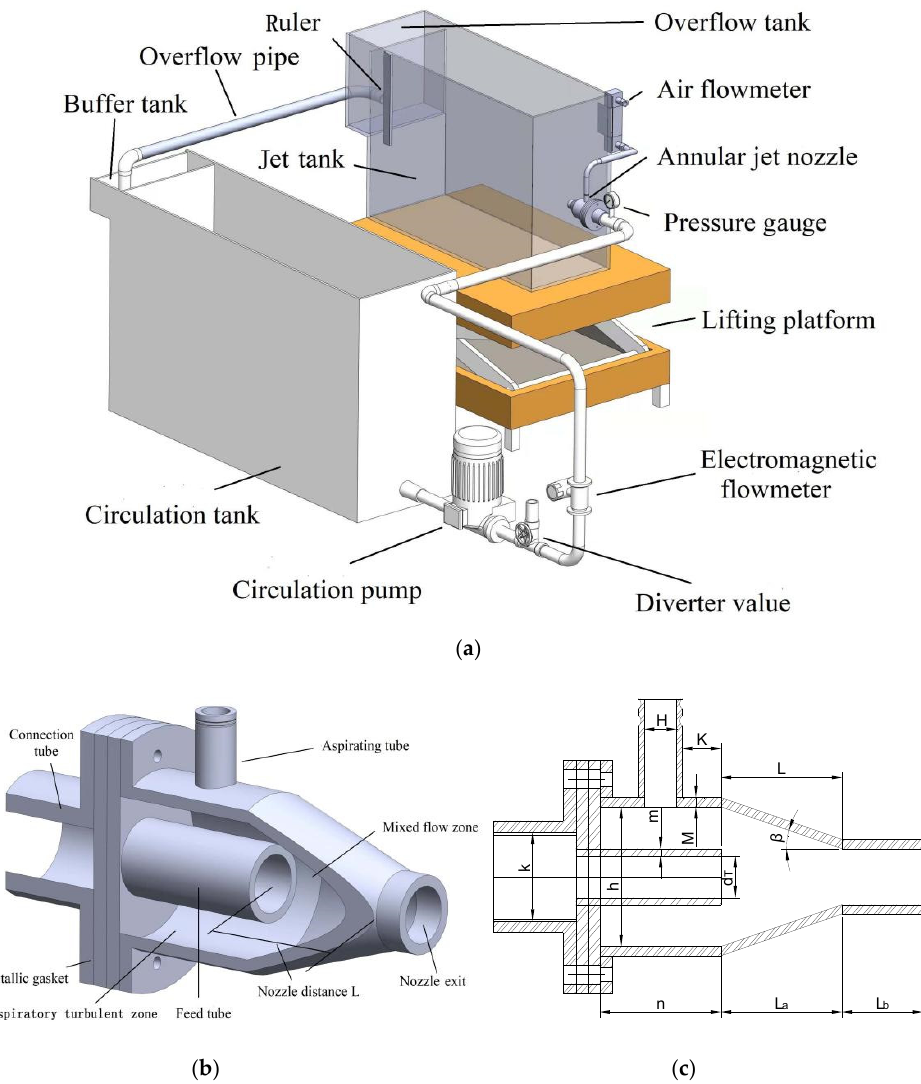
Figure 1. Experimental test system. ( a ) Diagram of test system; ( b ) Structural diagram of annular jet nozzle. ( c ) Sectional view of annular jet nozzle.